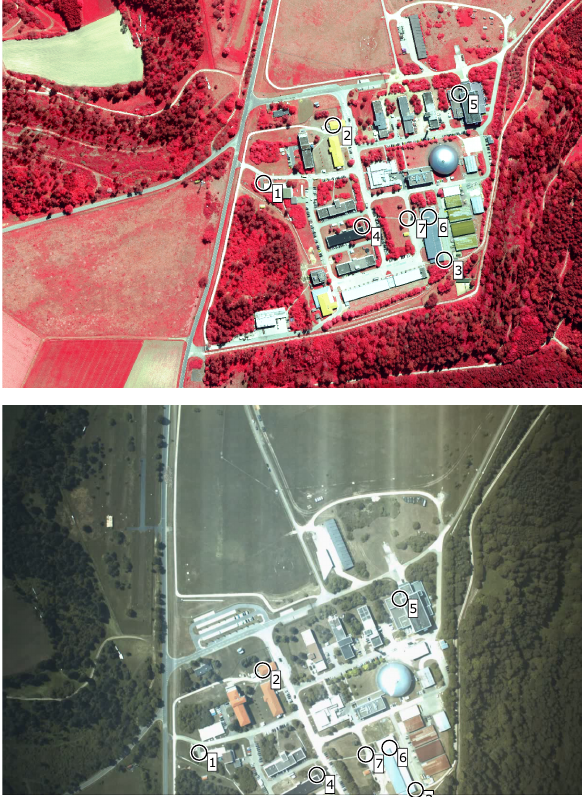
Figure 2. Image pair and seven selected tie points used for the investigations. Top: color infrared image serving as the re- ference image. Source: Geobasisdaten: Bayerische Vermes- sungsverwaltung. W Terms of use. Bottom: RGB